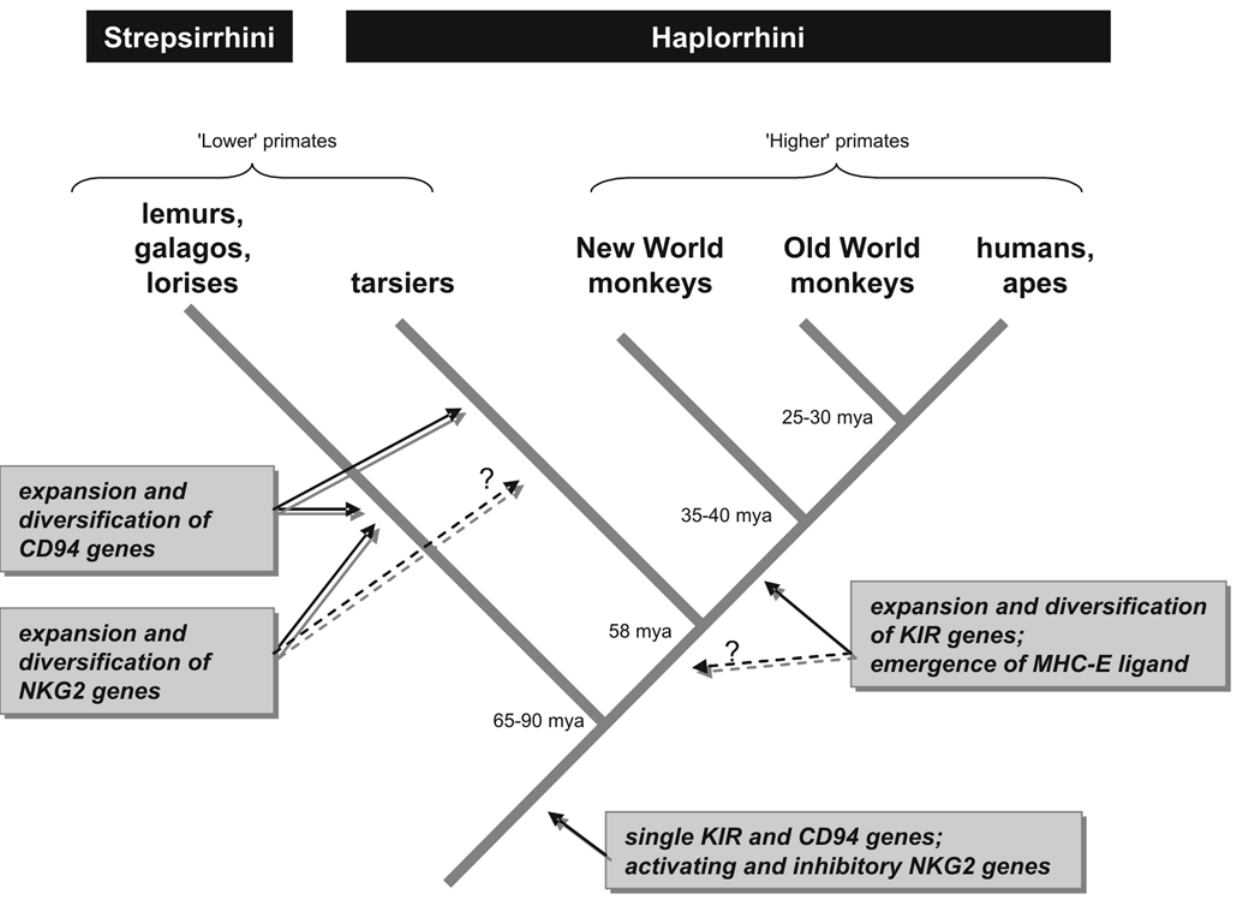
Figure 8. Model of NK cell receptor evolution in primates.